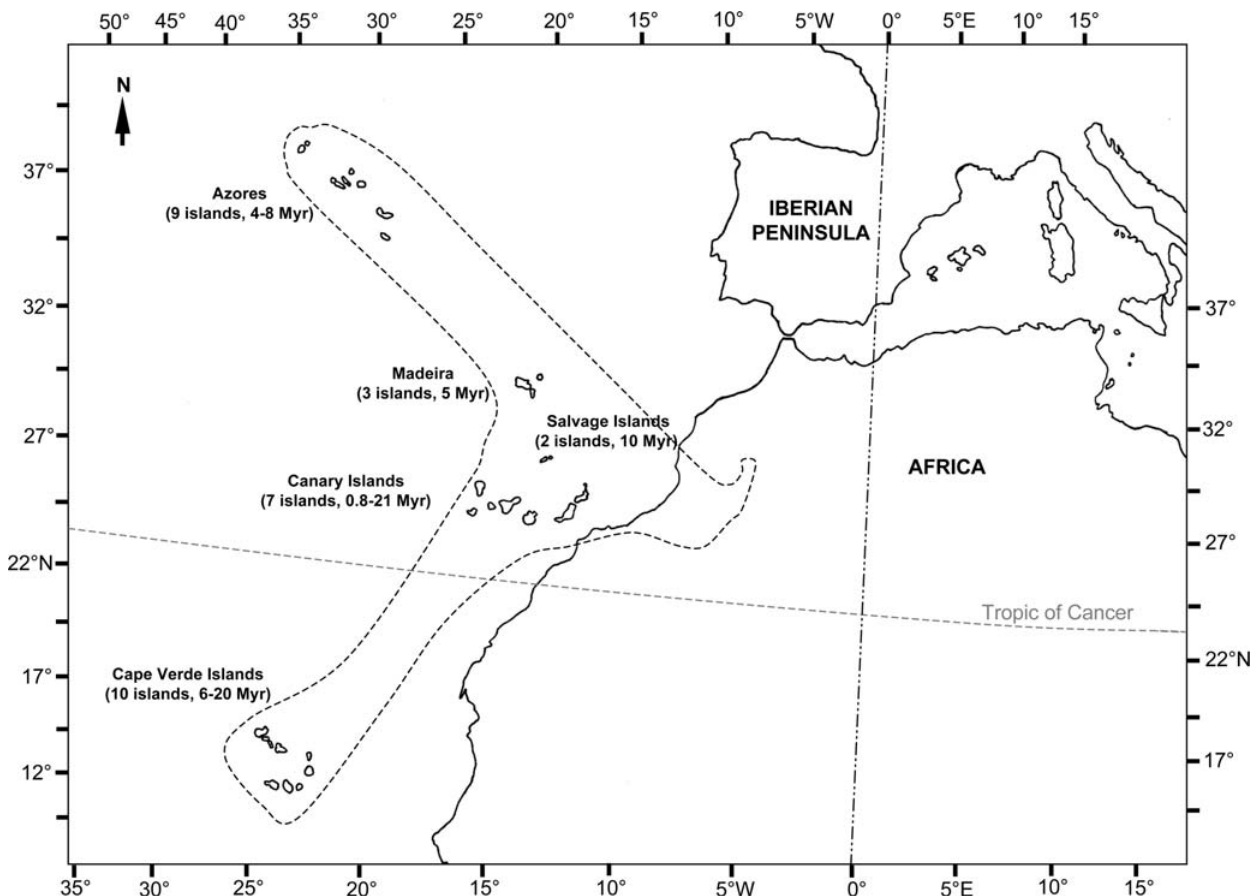
Figure 1. The phytogeographic region of Macaronesia, including five Atlantic volcanic archipelagos (the Azores, the Madeiras, the Salvage Islands, the Canary Islands, and the Cape Verde Islands). The age of current above-sea landmass for each island is from [2].